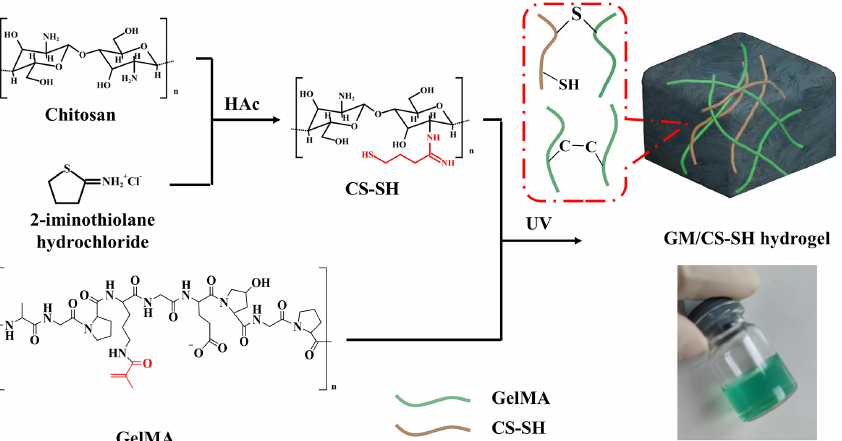
Figure 1. Schematic illustration of the synthesis of CS − SH and the fabrication of GCH. The 3D polymer networks of GCH consist of the polymerization of GelMA and the Thiol-ene reaction between GelMA and CS-SH.